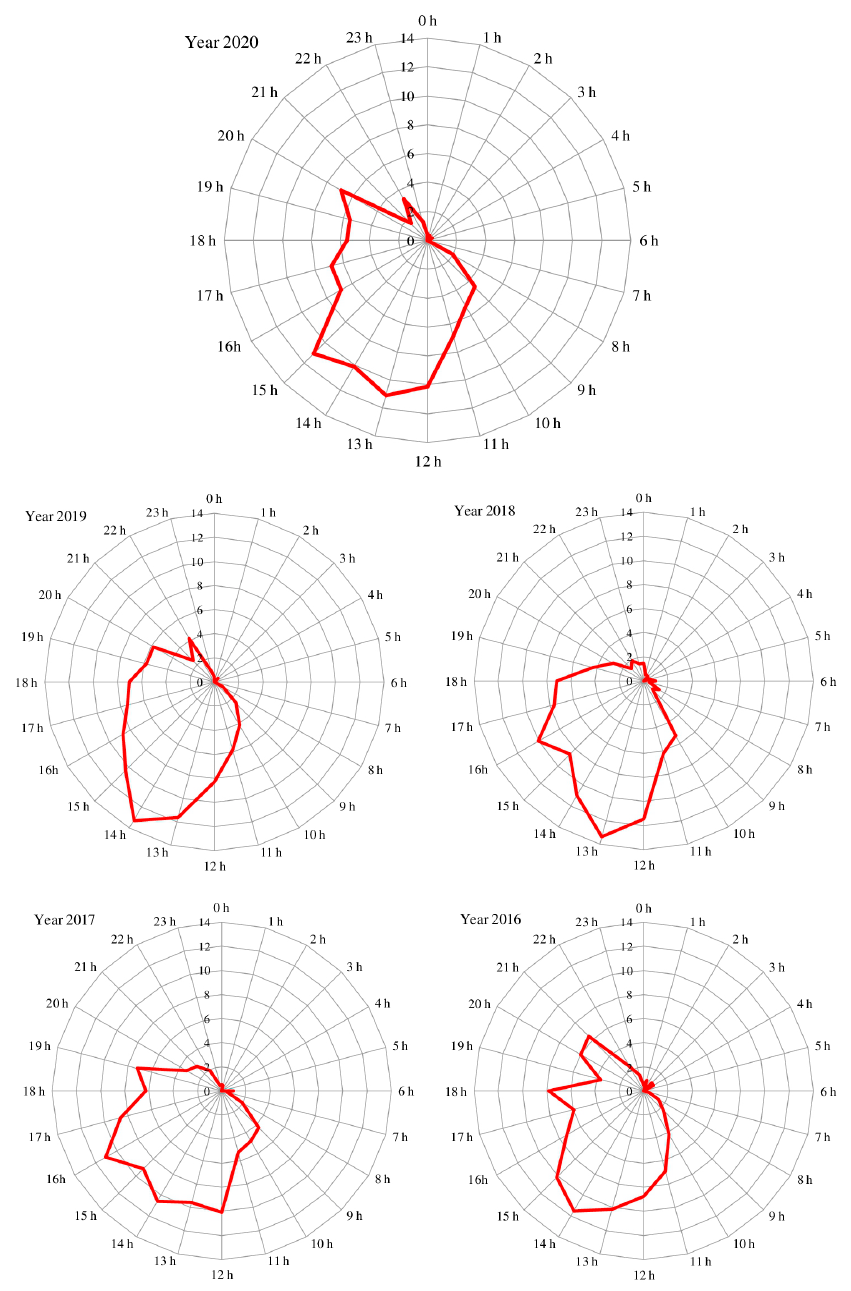
Figure 4. Relative frequency of the hourly distribution of rescues.